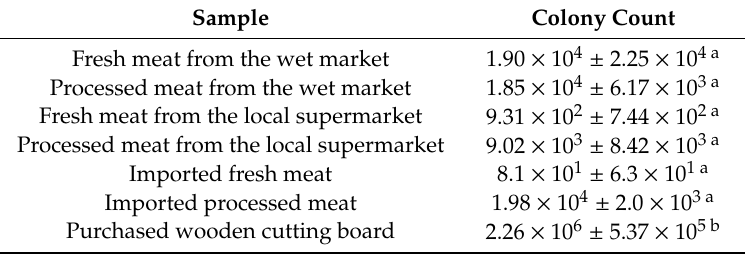
Table 1. Colony counts for the wooden cutting board and meat